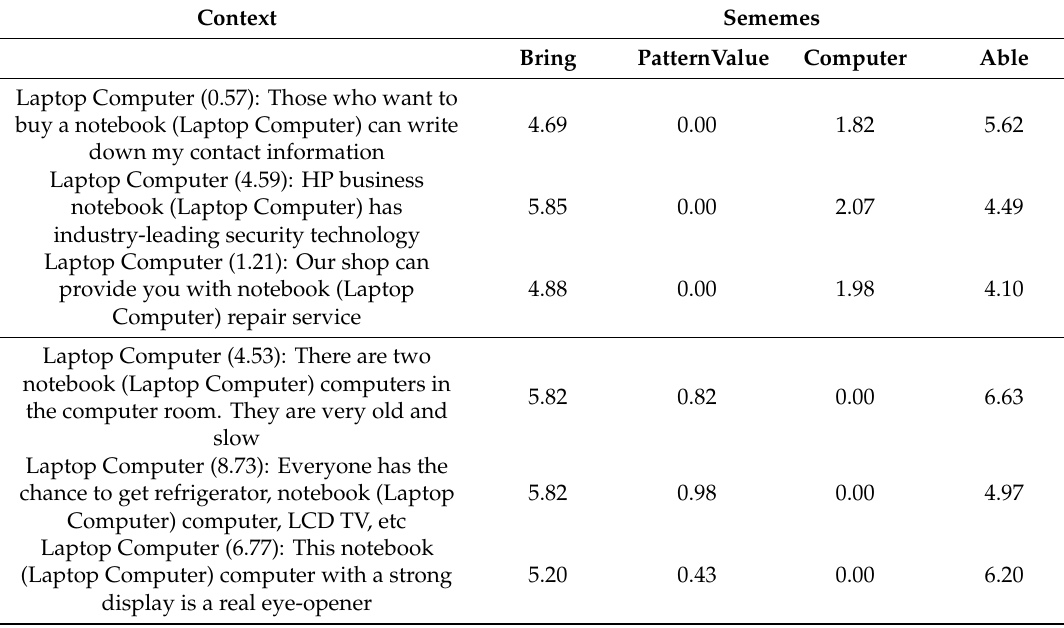
Table 8. The impact of context on the weight of sememes. The values in this table represent relative weights and the relative weight of the sense “Notebook” is 0. Word: “Notebook” (Sense 1: “Notebook” (Sememe: “account”); Sense 2: “Laptop Computer” (Sememe: “bring”, “PatternValue”, “computer” and